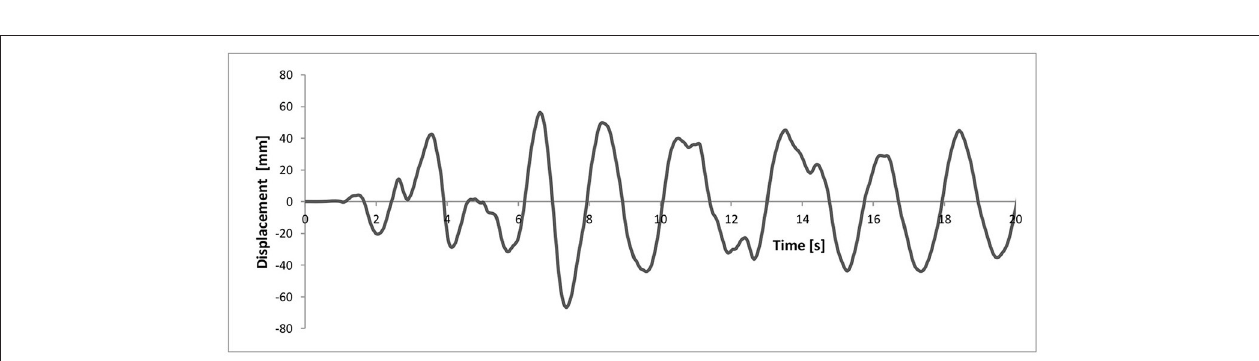
Frontiers in Built Environment | www.frontiersin.org